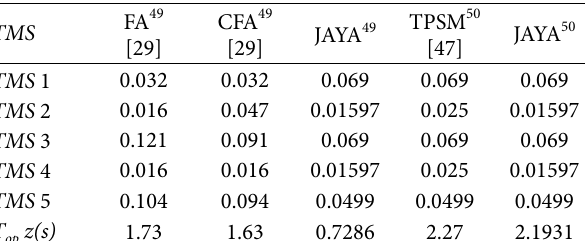
Table 14: Optimal TMS values for Case